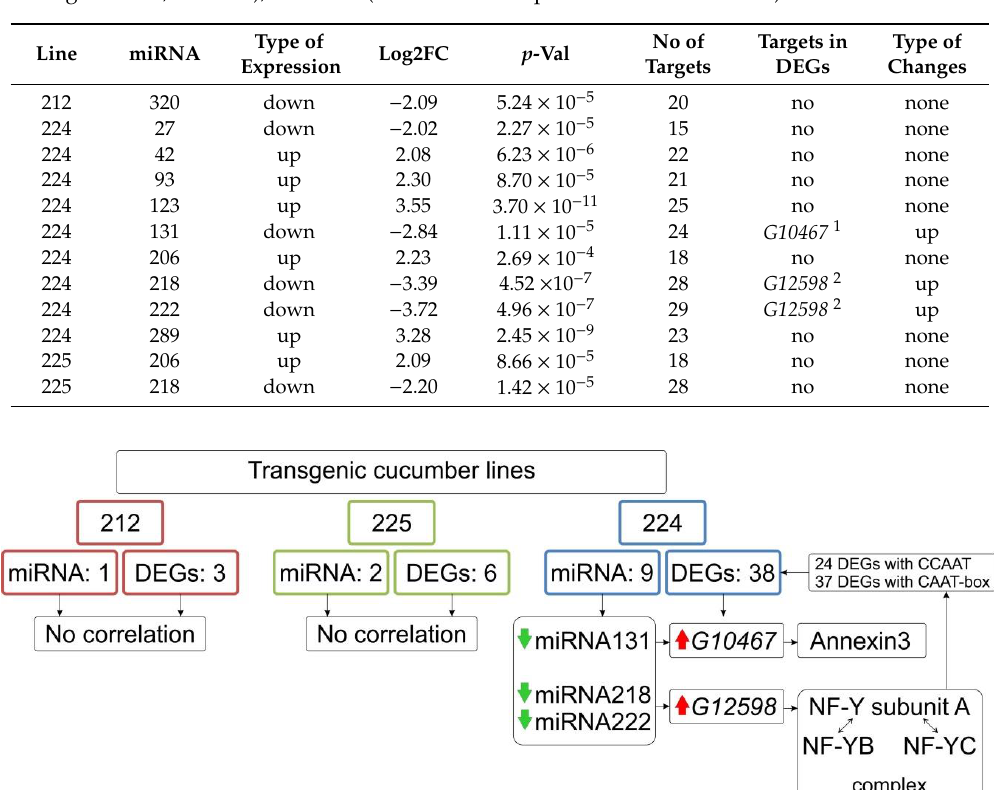
Table 2. Differentially expressed miRNAs in transgenic lines (212, 224, and 225). 1 G10467 (ion binding-calcium, annexin), 2 G12598 (Nuclear transcription factor Y subunit A).